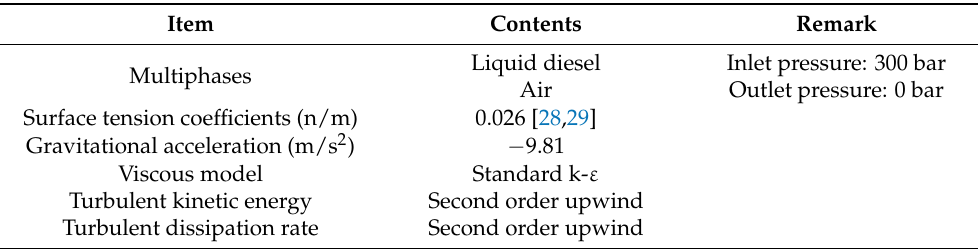
Table 4. Summary of spray simulation model.